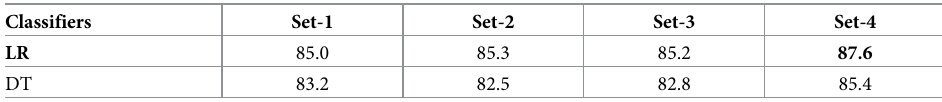
Table 4. Comparison of two classifier’s accuracy (%) over various holdout